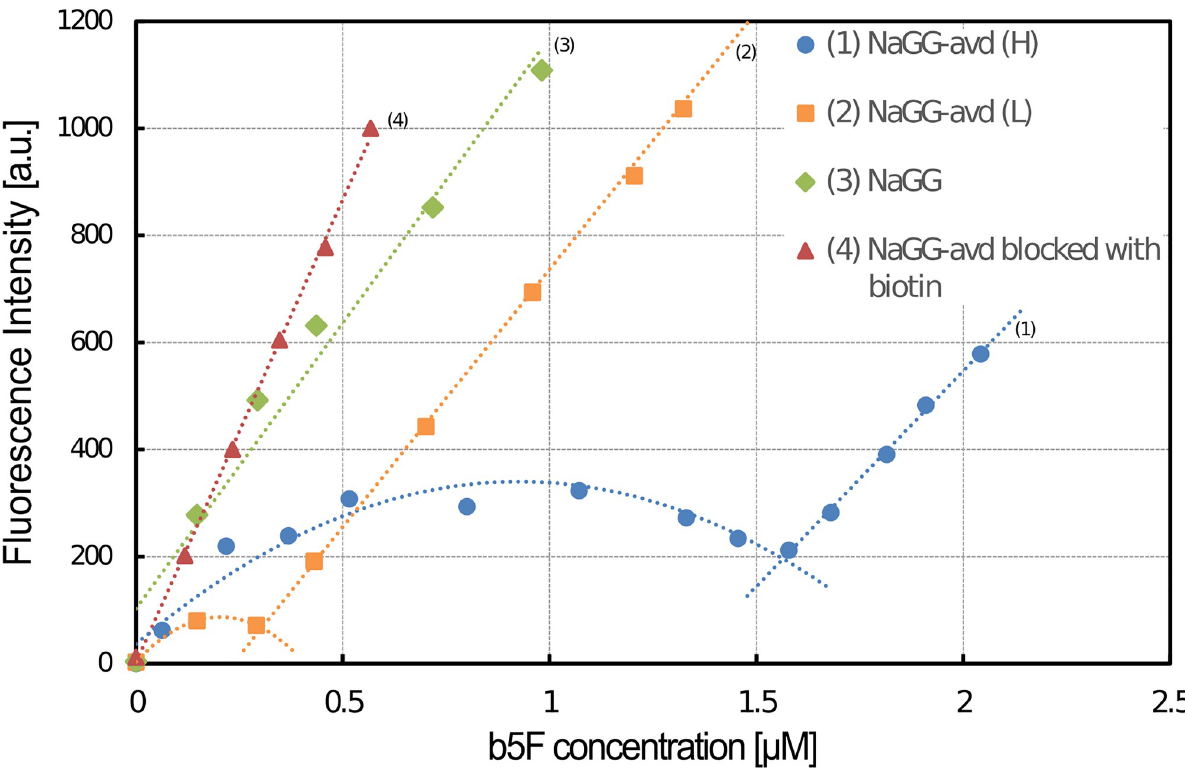
Fig 2. Fluorescence titration curves with step-wise addition of b5F. Non-functionalized NaGG (green) and functionalized NaGG-avd blocked with biotin (red) show a linear curve, whereas functionalized NaGG-avd (yellow and blue) with available biotin-binding sites show quenching behavior at low b5F concentration. From the intersection of quenched and linear parts the biotin binding site concentration can be deduced. From the intersection or linear and polynomial curves, the biotin-binding concentration was calculated.